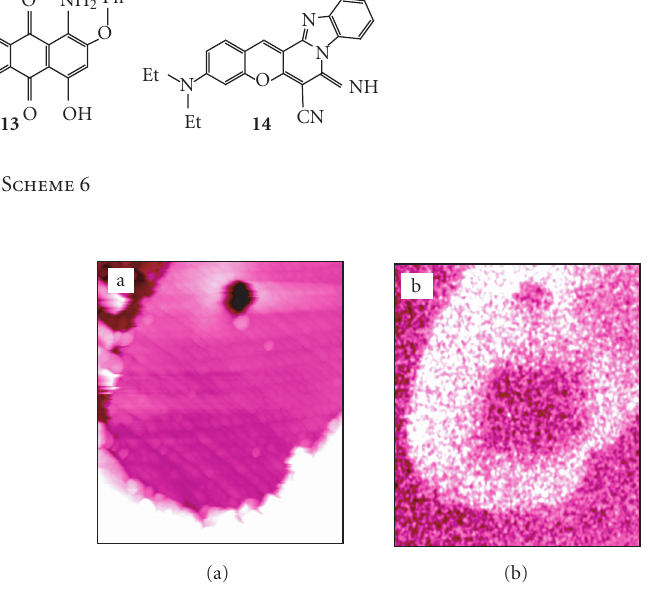
Figure 40: Simultaneous shear-force AFM (a) (50 μ m, Z range 3 μ m) and fluorescence SNOM (b) of a microtome cut surface of an evenly dyed polyester fiber (dye 12 ) in Technovit 7100 resin.